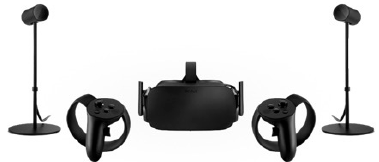
Figure 1. Peripheral hardware of the Virtual Reality Hand Controllers (VR-HC) system.